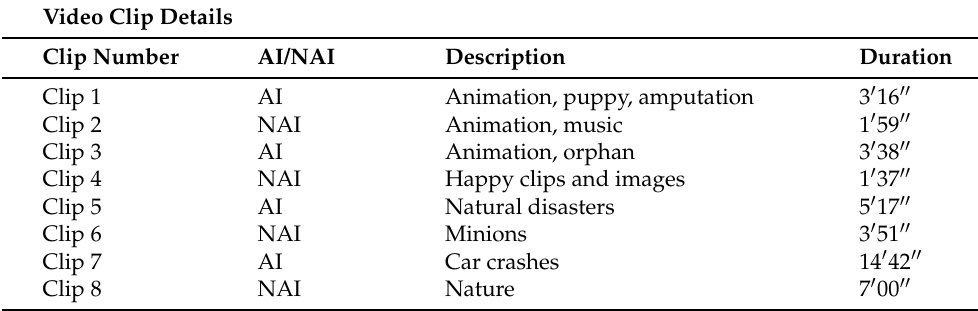
Table 1. Video clip details: clip number, anxiety-inducing (AI)/non-anxiety-inducing (NAI), description, and